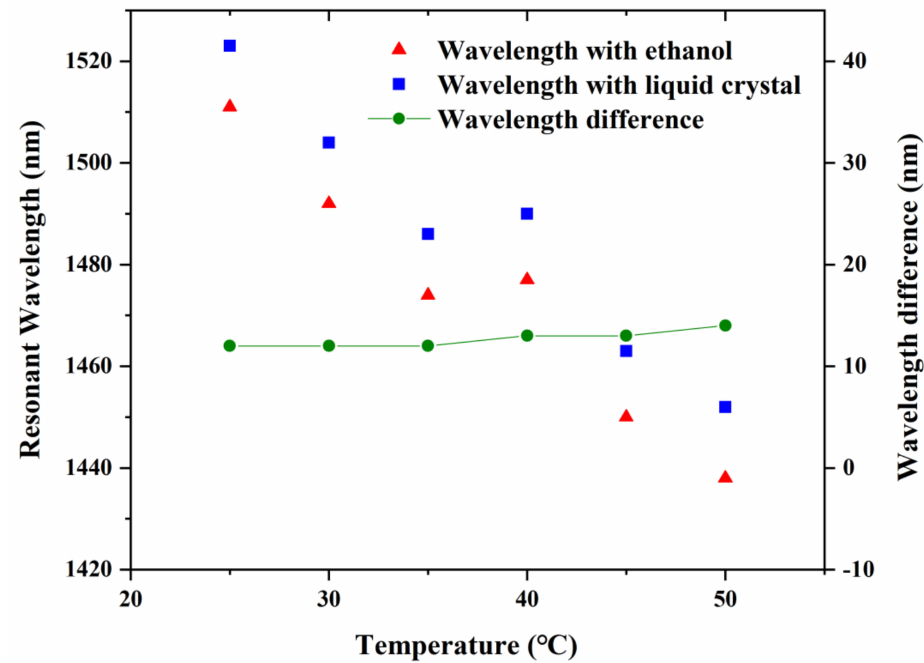
Figure 6. Wavelength shifts of the ethanol- and LC-infiltrated fiber, and wavelength difference between the two resonant wavelengths at the maximum